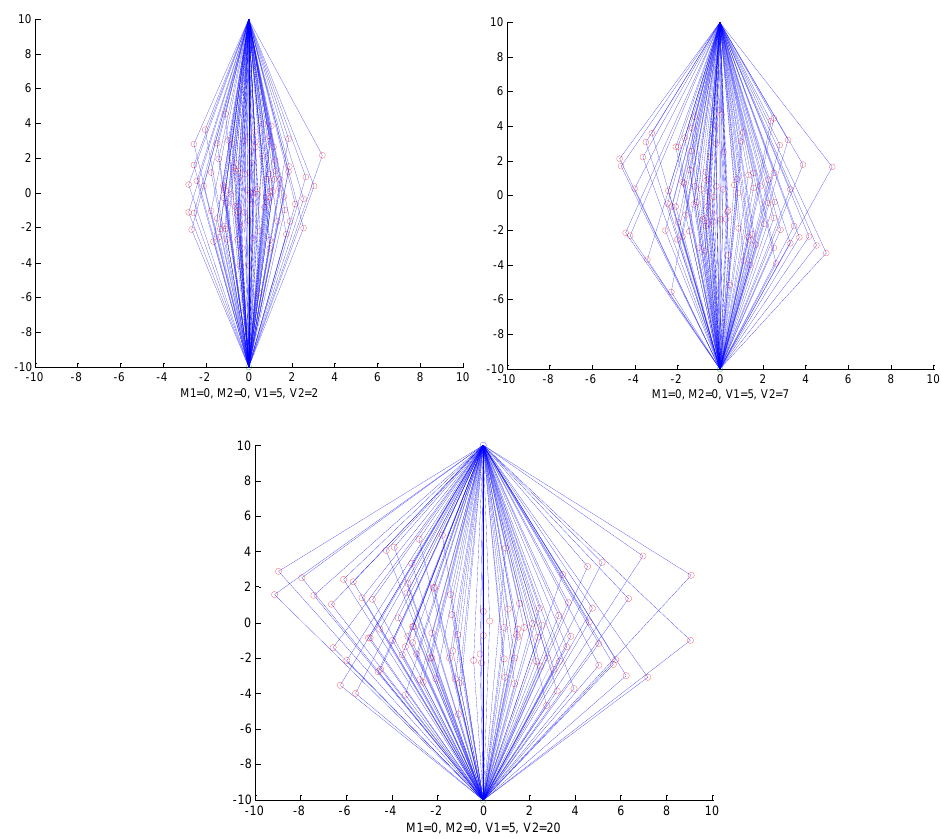
Figure 4. Distributions of agent nodes with different parameters.